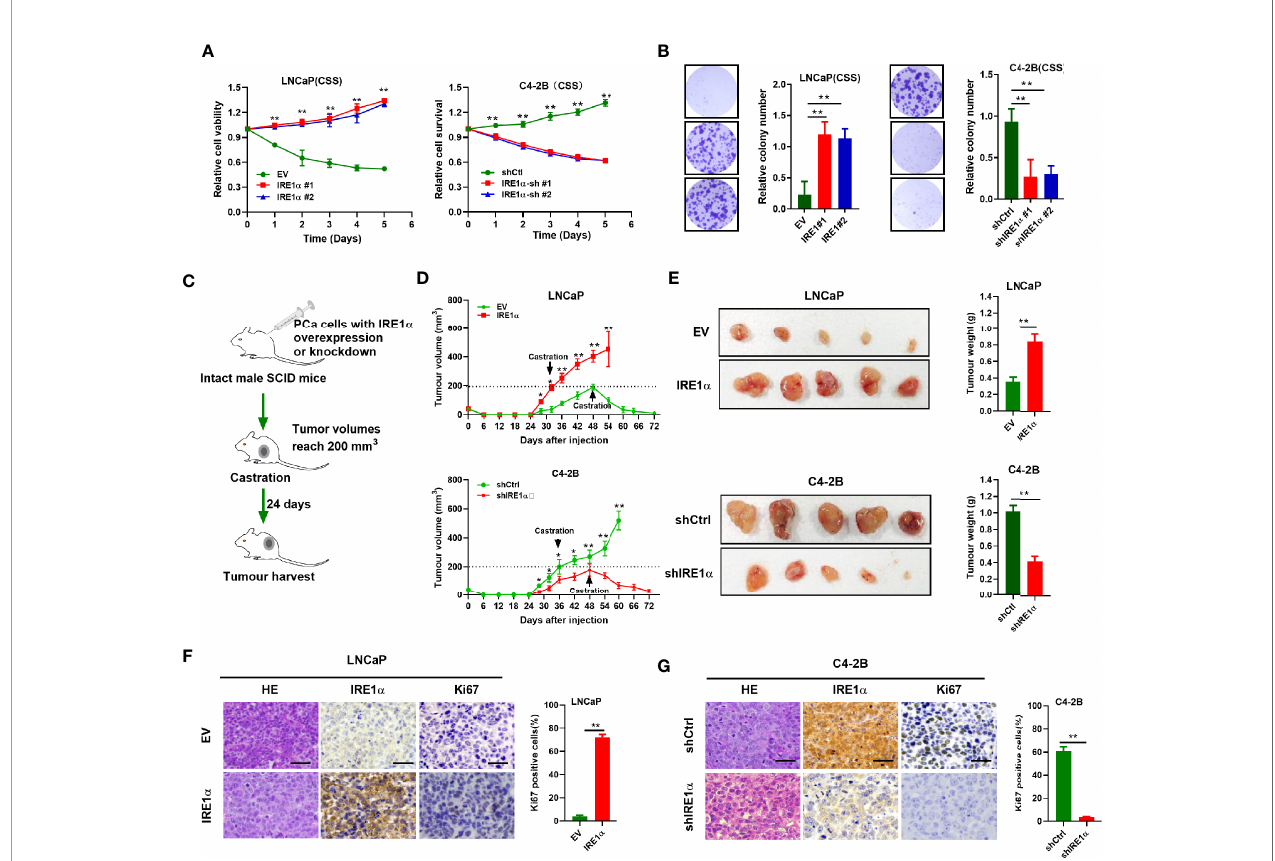
FIGURE 2 | IRE1 a overexpression promotes prostate cancer cells proliferation under the androgen-de fi cient condition. (A, B) MTS assay and colony formation assay of LNCaP cells with IRE1 a overexpression or C4-2B cells with IRE1 a knockdown, which were cultured in conditions with CSS. (C) The in vivo experiments investigated the effect of IRE1 a expression on the proliferation abilities of prostate cancer cells in non-castrated and castrated male SCID mice. (D, E) Growth curve and tumors volumes shows the growth patterns of tumors formed by LNCaP cells with IRE1 a overexpression or C4-2B cells with IRE1 a knockdown, fi rst grown in intact mice, followed by another 24 days postcastration in the same hosts. (F, G) Representative HE and IHC staining images of IRE1 a and Ki-67 in xenograft tumor treated as indicated (Scale bar, 100 m m). shCtrl, negative control short hairpin RNA; shIRE1 a , short hairpin RNA against IRE1 a ; EV, cells transfected with empty vector; IRE1 a , cells transfected with IRE1 a expression vector. Data shown are the mean ± SD from three independent experiments, **P <